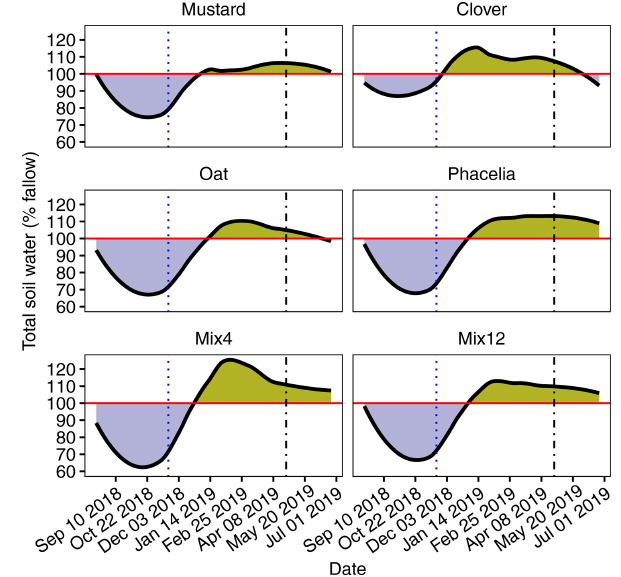
Figure 1. Volumetric soil water content down to 80cm soil depth, with fallow as a 100% reference (red horizontal line). Blue areas mark soil water content below the fallow level and yellow/brown values above. Continuous black lines were achieved by logistic re- gression models from three replicates, and the differences between the treatments at the individual sampling dates are provided in Ta- ble S3. The blue dotted line marks the termination of CC, and the vertical dashed line marks the seeding date of the main crop